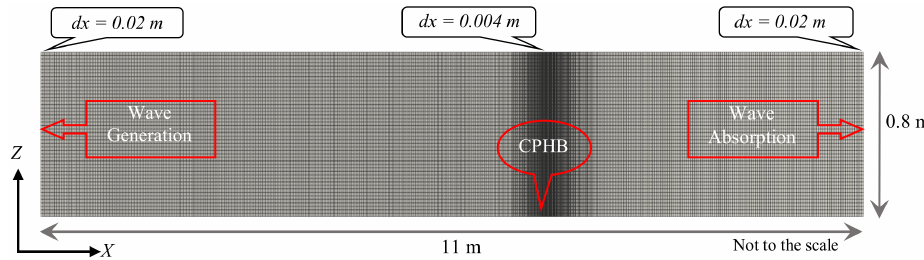
Figure 7. Typical representation of non-uniform grid in the numerical wave